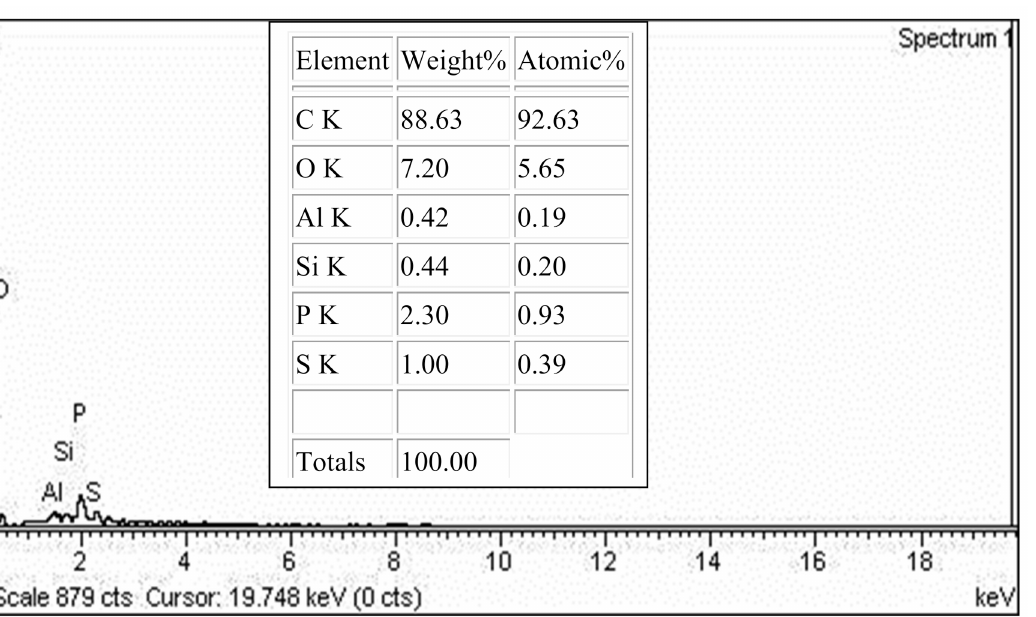
Figure 5. EDX analysis of prepared